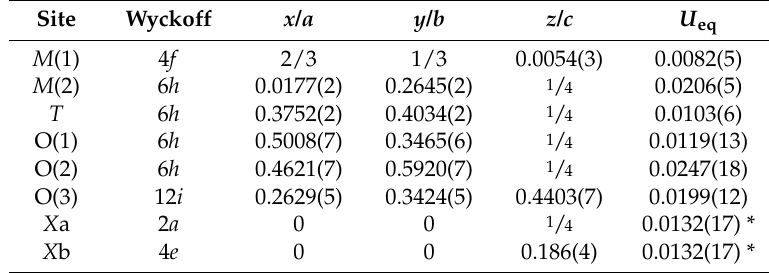
Table 3. Site labels, Wyckoff positions, atom coordinates, and equivalent isotropic or isotropic (*) displacement parameters (Å 2 ) for parafiniukite.